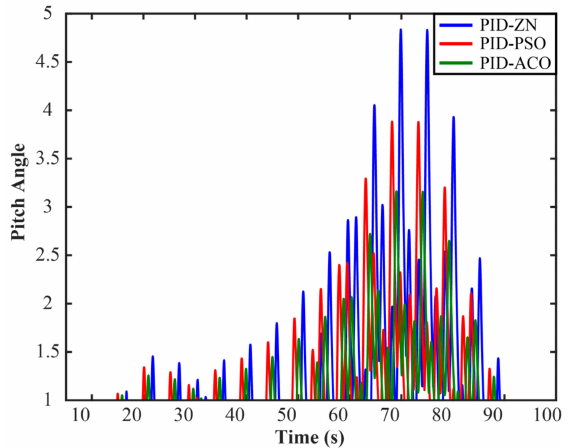
Figure 12. Pitch angle of the wind turbine